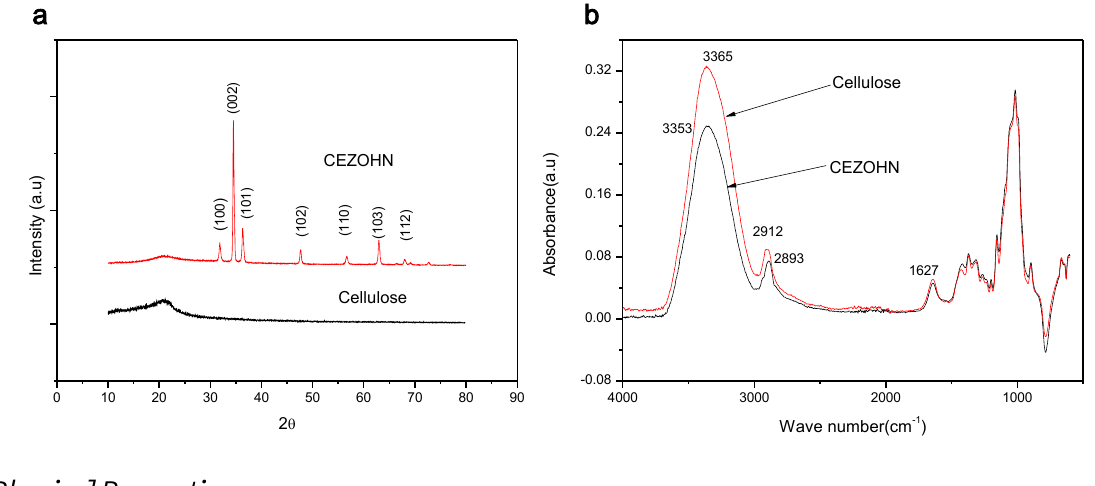
Figure 5. ( a ) XRD result and ( b ) FTIR result of CEZOHN and cellulose.